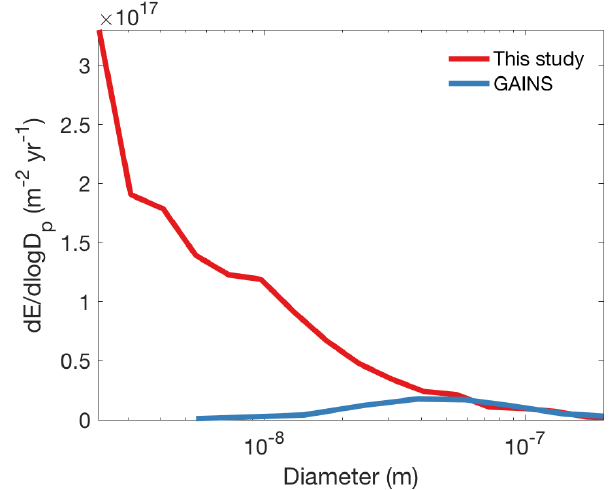
Figure A8. Annual sum of particle number emissions at different sizes (normalized with the width of each size bin) based on particle number emissions calculated for non-NPF event days in this study (red line) and the GAINS model (blue